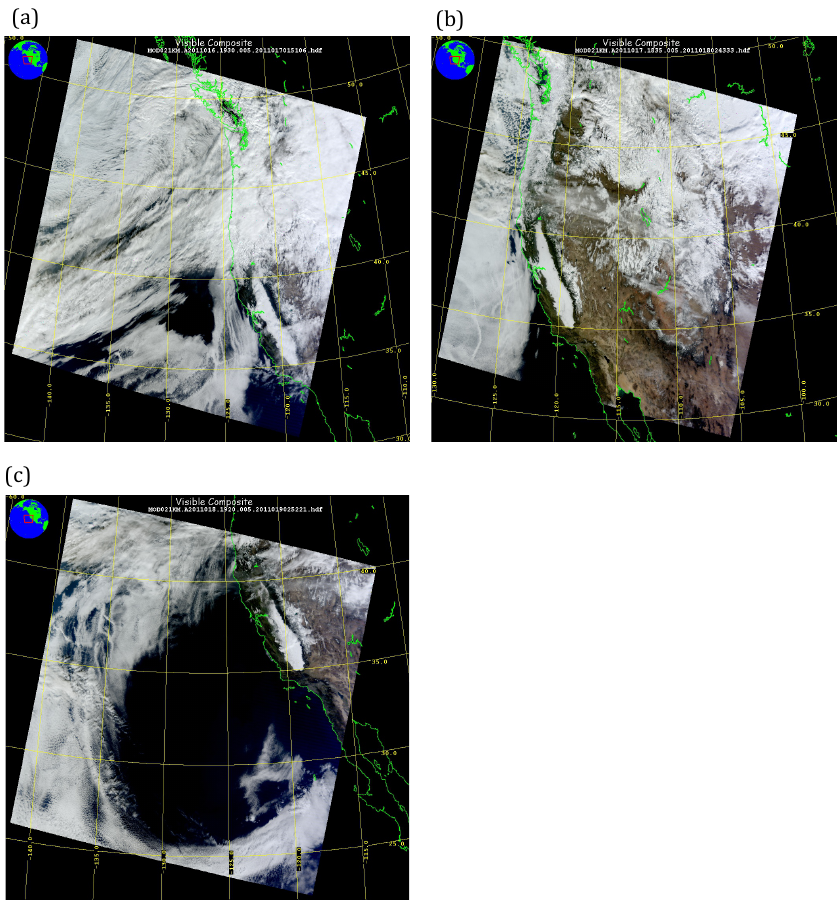
Figure 2. MODIS true color images at (a) 19:30UTC on 16 January, (b) 18:35UTC on 17 January and (c) 19:20UTC on 18 January 2011 from the Terra satellite. Table 2. California Ambient Air Quality Data (CAAQD) station information. Station ID Station